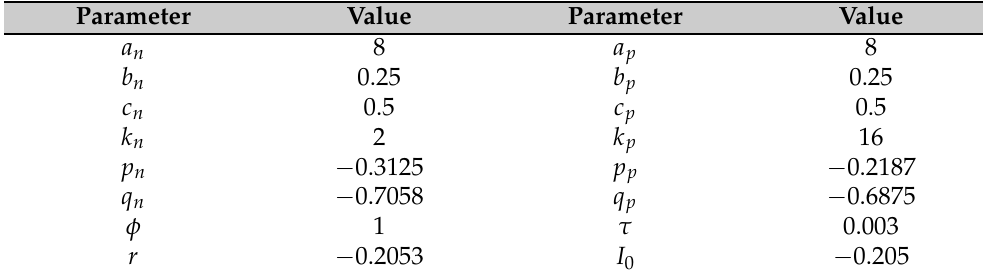
Table 1. Different Parameters for Reproducing the Class I Pattern. Parameter